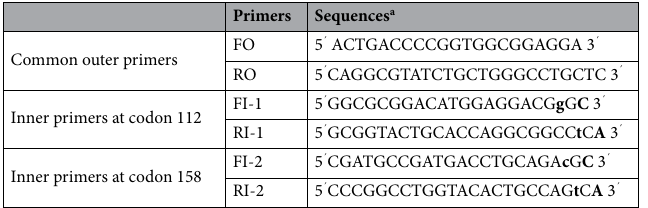
Table 3. Multiplex T-ARMS PCR primers for APOE genotyping. a The boldface lowercase letters are a deliberate mismatch, and the boldface uppercase letters are an allele-specific